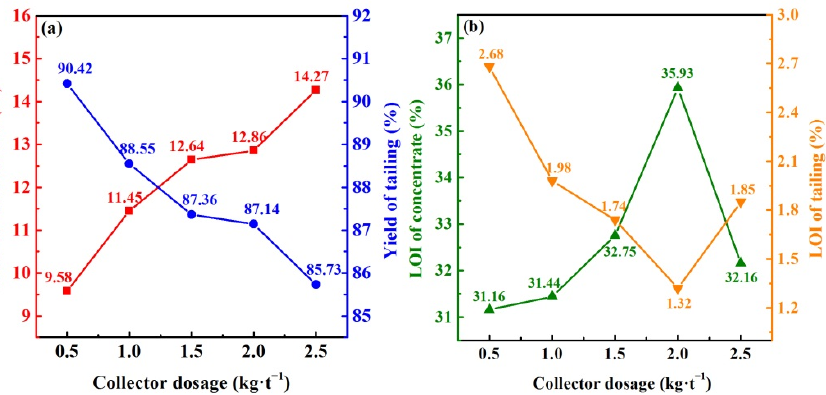
Figure 3. Effect of collector dosage on the flotation performance of FEBFS samples: ( a ) yield of flotation product and ( b ) LOI of flotation product.